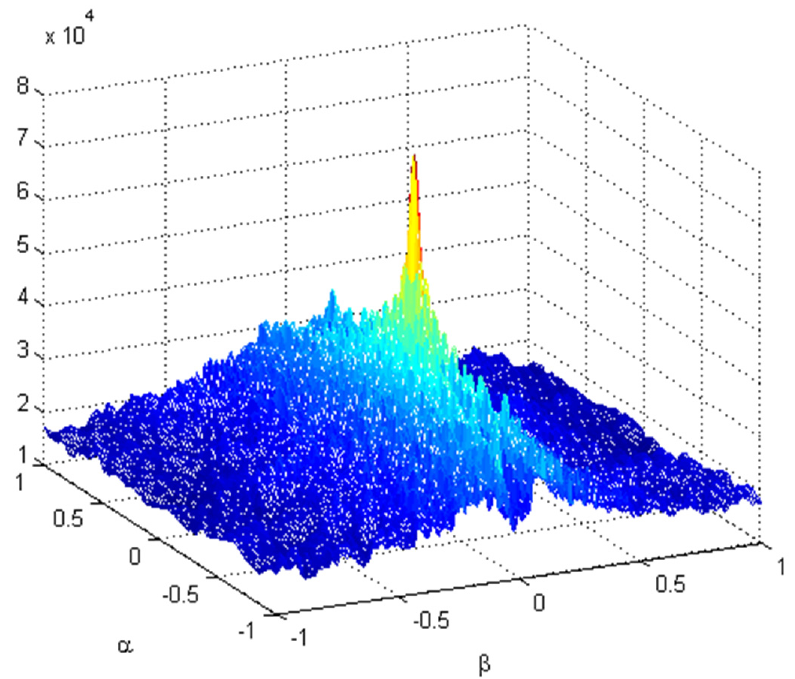
Figure 8. Coarse estimation results with the GRFT method.